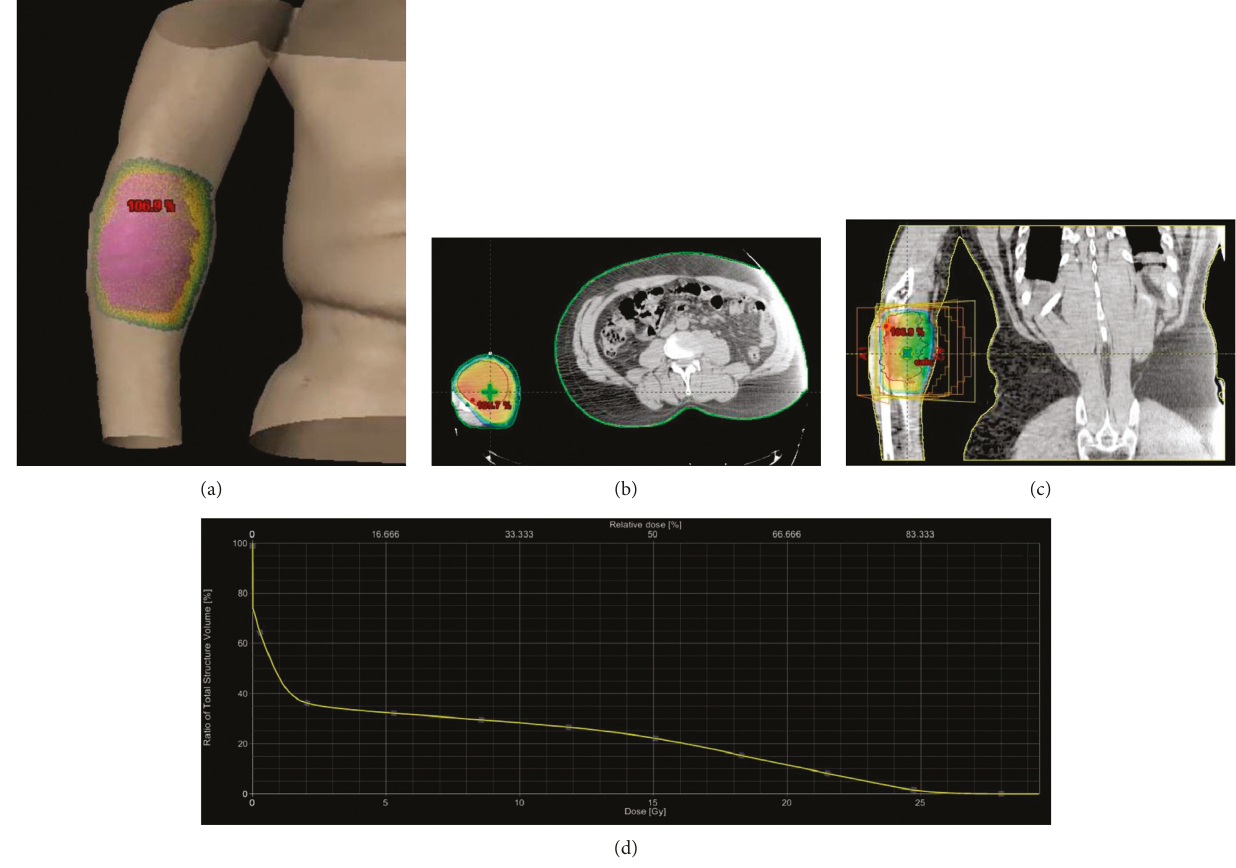
Figure 1: Radiotherapy planning with two oblique fields. Radiotherapy field with (a) three-dimensional model view, (b) axial view, and (c) coronal view. (d) Dose-volume curve demonstrates that the skin D 50% was 15.2Gy. Mean dose of skin was 13.1 Gy, and the maximum dose was 29.4